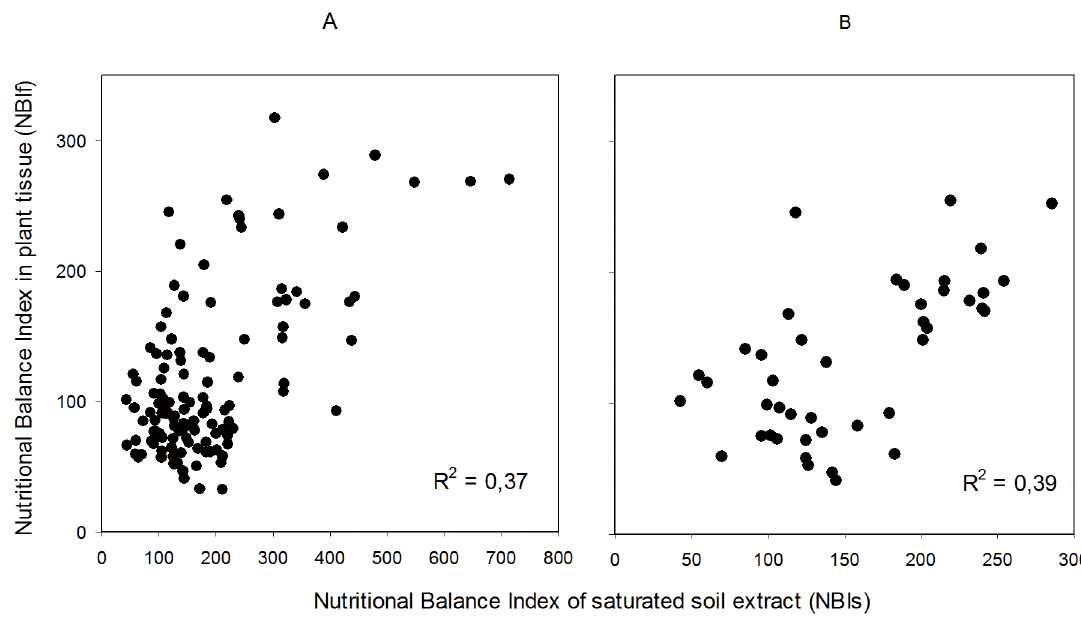
Fig 2. Correlations between NBIf (plant tissue) and NBIs (SSE) index. Electric Conductivity (EC) restriction. (A) EC range: 1.1 and 5.8 dS m-1. p < 0.001n = 124. (B) EC range 1.8 and 2.5. p < 0.001n = 35.